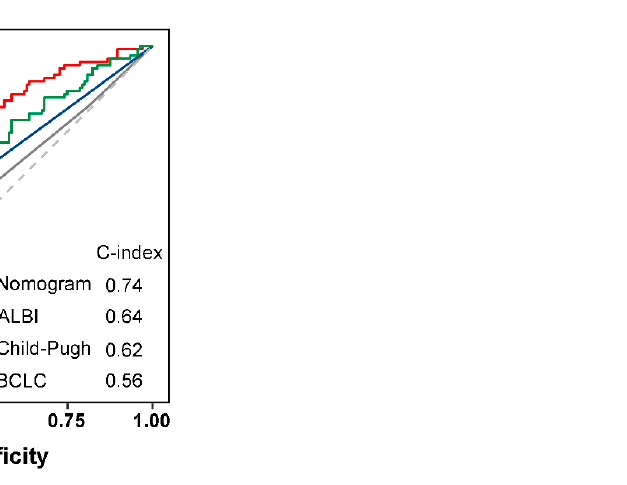
11 of 16 Figure 4. The C-index of the nomogram for the prognostic prediction of OS in the training cohort ( A ) and validation cohort ( B ). The calibration curves of OS based on nomogram prediction and the actual observation in the training cohort ( C ) and validation cohort ( D ). Child − Pugh grade, ALBI score, and BCLC were utilized to predict the prognosis of HCC. To further evaluate the clinical value of the PGA grade, we compared the perfor-